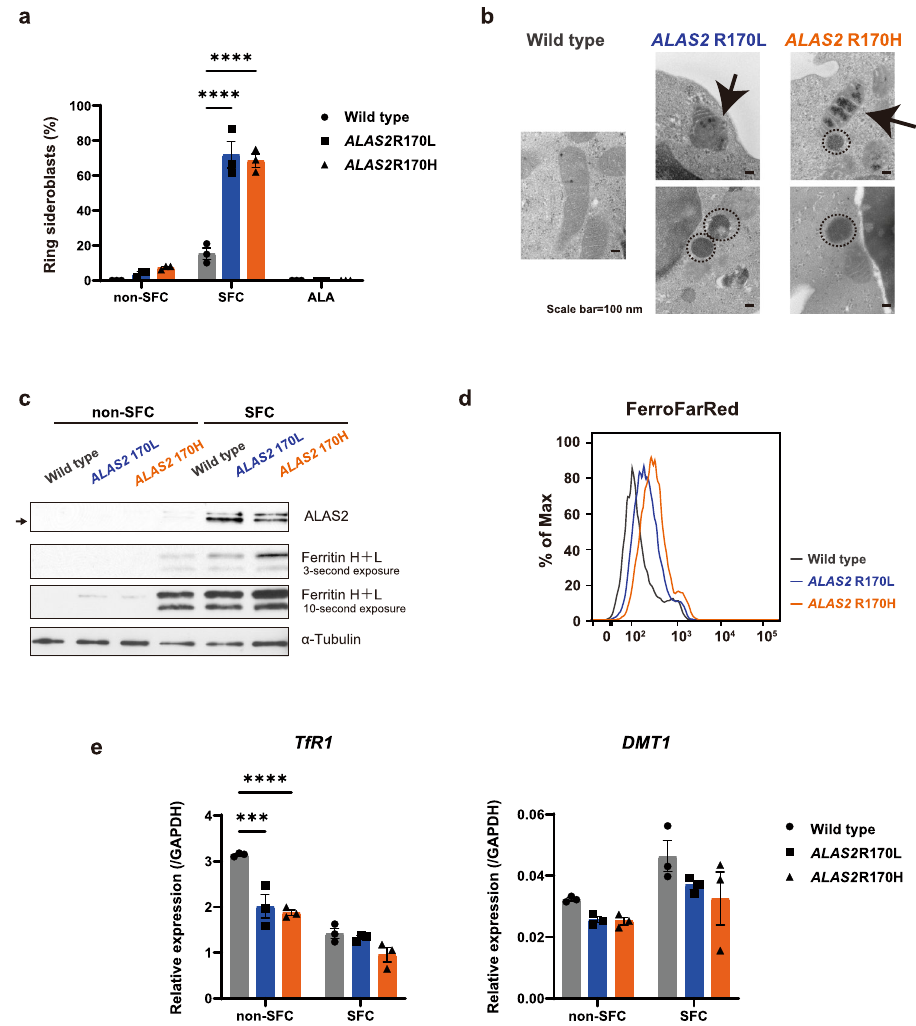
Figure 3. ALAS2 mutations result in iron overload. ( a ) Count of ring sideroblasts of HUDEP-2 clones after 6 day differentiation without sodium ferrous citrate (SFC), with SFC and with 5-aminolevulinic acid (ALA) (n = 3). Error bars represent the standard error of the mean. Each P value was calculated using Tukey’s test after a two-way analysis of variance. **** P < 0.0001. ( b ) Images of electron microscopy in HUDEP-2 clones after differentiation with SFC. Arrows indicate aberrant mitochondrial iron deposits. The portions surrounded by a dashed line indicate mitochondrial spheroids. ( c ) Western blotting for ALAS2, ferritin and α-tubulin in HUDEP-2 clones after differentiation with or without SFC. The cropped gel images are delineated, and the uncropped images can be found in Supplementary Fig. S7. In ( b ) and ( c ), the representative images of three independent experiments are shown. ( d ) Intracellular labile iron of HUDEP-2 clones after differentiation with SFC. The fluoroprobe FerroFarRed was used for a marker of intracellular labile iron. The representative histogram of three independent experiments, plotted using FlowJo version 7.6.5 software (TreeStar, Ashland, OR, www. flowjo. com), is shown. ( e ) Quantitative reverse transcriptase-polymerase chain reaction analysis for TfR1 and DMT1 , expression relative to GAPDH in HUDEP WT , HUDEP R170L , and HUDEP R170H (n = 3). In a and e, graphs were plotted using GraphPad Prism 9 (GraphPad Software, San Diego, CA, www. graph pad.